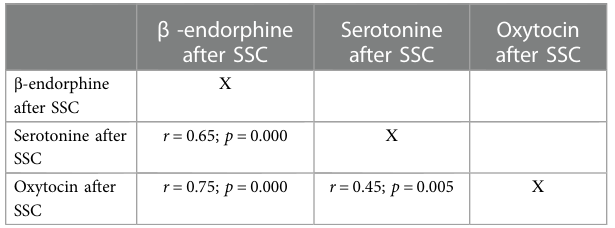
TABLE 4 Correlation matrix of baseline β -endorphin, serotonin, and oxytocin levels. Baseline β - endorphine Baseline serotonine Baseline oxytocin